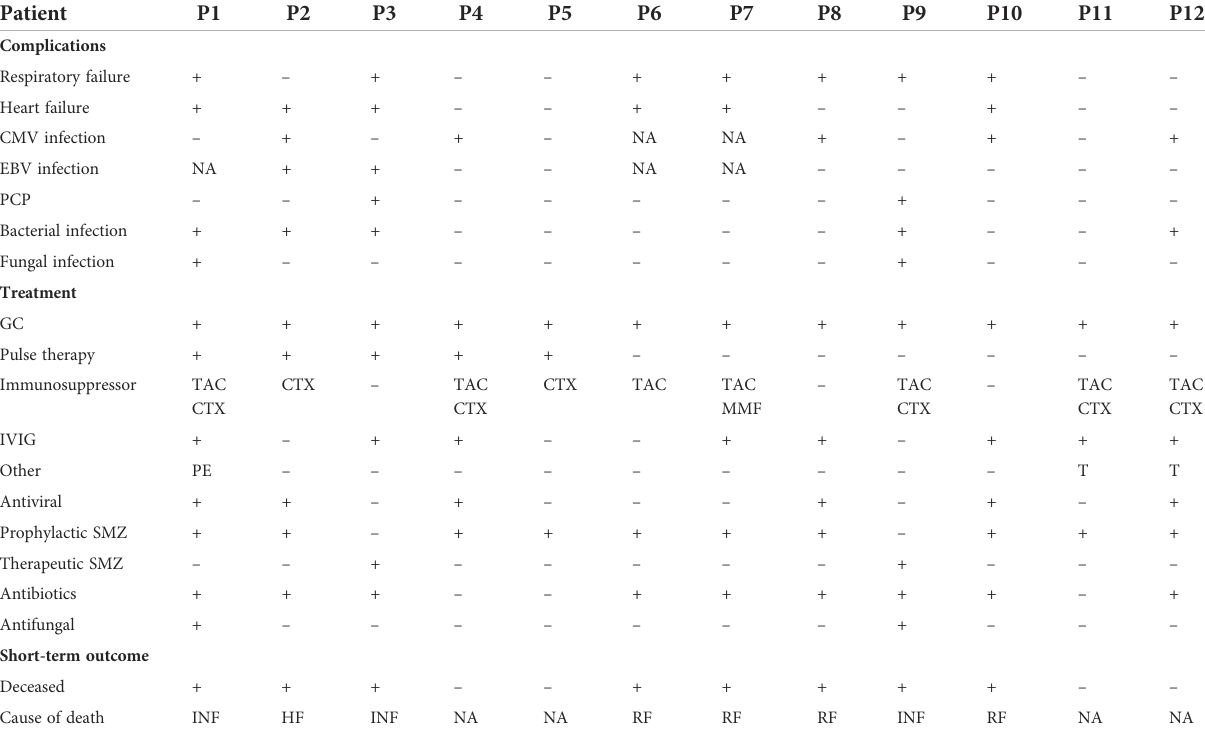
TABLE 2 Treatment and outcome of anti-MDA5 Ab+ DM/CADM patients with myocardial involvement. Patient